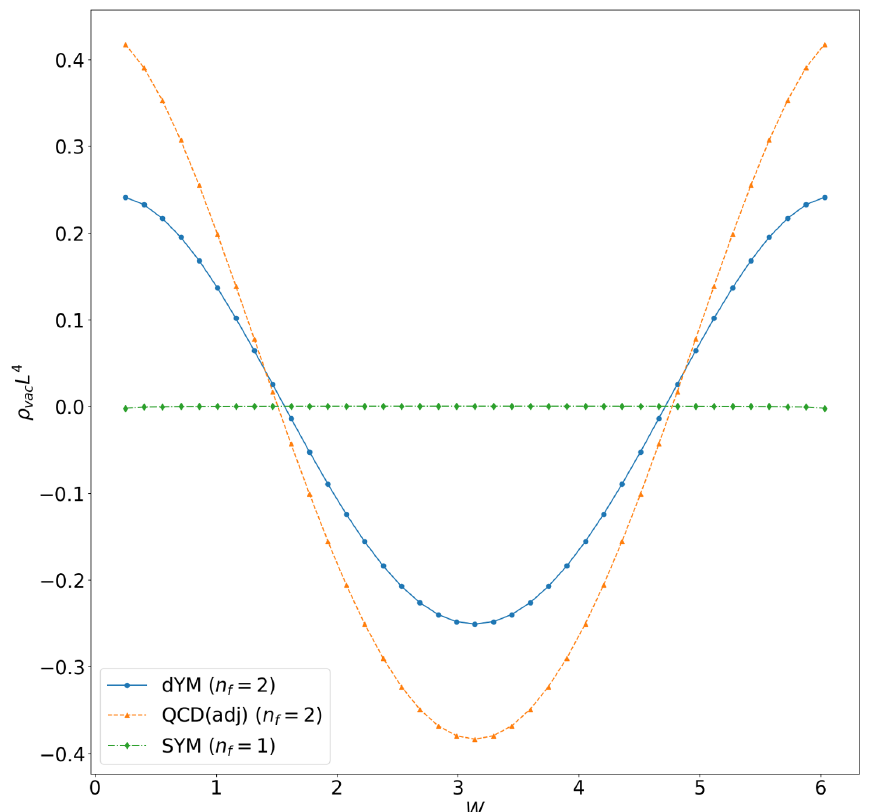
Figure 6 . The dimensionless vacuum energy as a function of the dimensionless parameter, W , for various theories. The dYM fermions are given mass LM = 1 . 0 , and the QCD(adj) and SYM are massless. The volume parameter is set to be (cid:15) = 0 . 01 . The numerical reliability breaks down near the boundary of the region without a tachyon, so the plot is only covers the values in the interval, hq q i . The value diverges down to negative infinity as W approaches the values 2 π(cid:15) 2 π(cid:15) , 2 π − 0 . 99 0 . 99 √ √ 2 π(cid:15) and W = 2 π − 2 π(cid:15) making the W = π vacuum metastable or slightly unstable for the W = case of